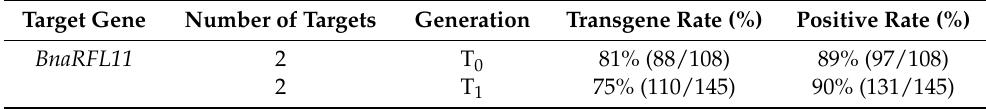
Figure 3. Different stages of the tissue culture process for Agrobacterium-mediated transformation in rapeseed. ( a ) Sowing of wild-type Westar seeds on the seedling medium (M0). ( b ) Growth of plants on seedling medium after 6–7 days. ( c ) Spreading of hypocotyls for 48 h in the dark on (M1) media. ( d ) After 48 h, transfer explants were transferred to (M2) media and placed in a growth room for 15–20 days. ( e ) After 15–20 days, explants were on (M3) media for callus induction until the plants were regenerated. ( f ) Regenerated plants were transferred into (M4) rooting media to obtain better roots. ( g ) After obtaining roots, transgenic plants were transferred into pots under controlled conditions for their survival. ( h ) Transgenic plants were transferred to the field under normal conditions after survival. Bar = 4 cm. Table 1. Statistical results for the bnarfl11 transgenic